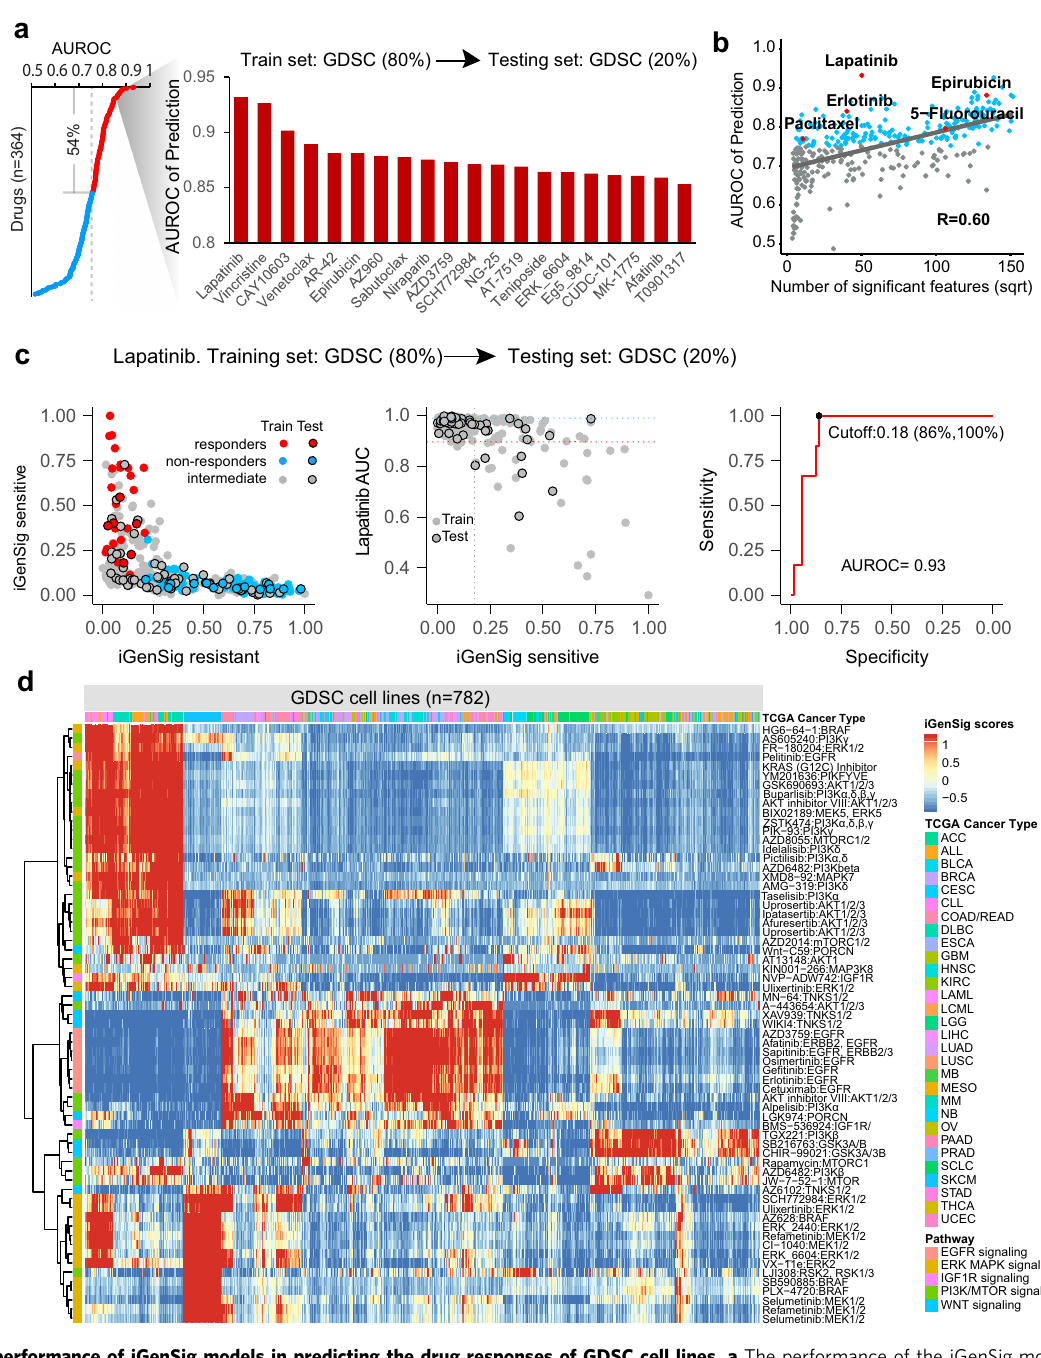
Fig. 2 The performance of iGenSig models in predicting the drug responses of GDSC cell lines. a The performance of the iGenSig models for GDSC pro fi led drugs was assessed by their average AUROC. About 364 drugs that show a negatively skewed drug response distribution in cancer cell lines and have at least 20 sensitive cell lines are included in the analyses. The drugs with top-performing models (AUROC >0.85) are shown in bar chart on the right. The average AUROC for each drug was calculated based on fi ve train/test sets. b Correlating the performance of the iGenSig models for 364 drugs with their average number of signi fi cant genomic features. The drug models assessed on the six clinical trial datasets are highlighted in red. c the performance of the iGenSig model for Lapatinib in predicting the response of GDSC cell lines based on a representative training and testing set. Left, sensitive, and resistant GenSig scores for GDSC cell lines. Middle, the correlation of the iGenSig scores with AUC measurements for Lapatinib. Right, the receiver operating characteristic (ROC) curve for predicting sensitive responses to Lapatinib. As the golden standard for the ROC curve, the cell line subjects in the test set are divided into sensitive and non-sensitive groups based on the AUC measurements for Lapatinib using the cutoff determined by the waterfall method (see Methods). d Ward D2 Hierarchical Clustering for GDSC cancer cell lines and targeted kinase drugs of fi ve RTK signalings based on iGenSig scores. The drugs targeting different kinases or different kinase families form distinctive